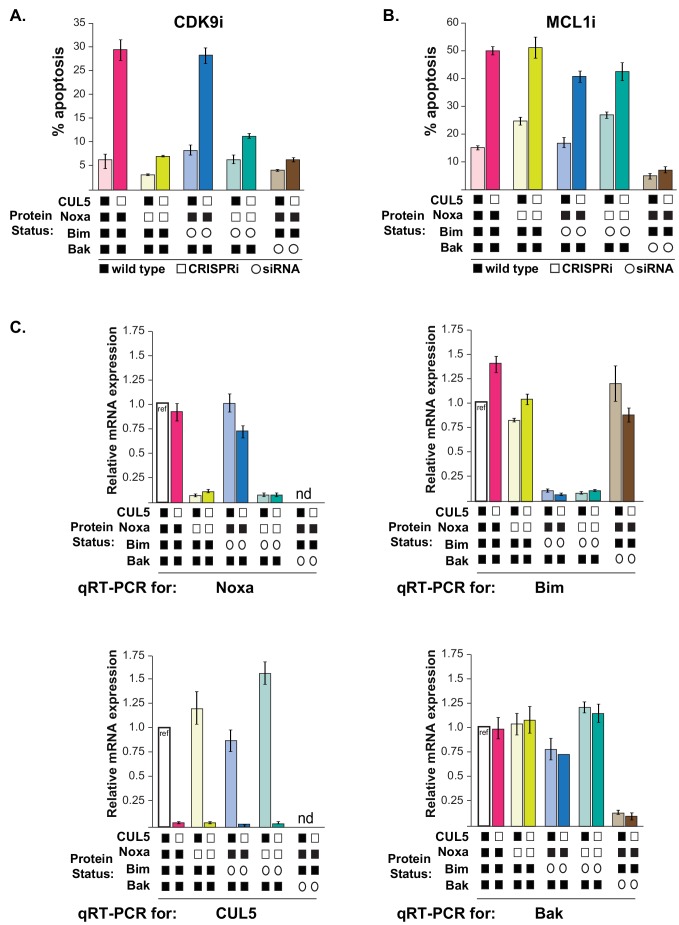
CUL5-kd cells regain resistance to CDK9i when Noxa is depleted.(A) As in Figure 5, CUL5 and Noxa were knocked down in dCas9-KRAB-expressing LK2 cells by selecting for corresponding sgRNAs. Bim and Bak were knocked down by siRNA. Apoptosis was measured using Cell Event detection by flow cytometry after treatment with 3 μM CDK9i for 6 hr. Bar graphs depict an independent set of transductions and siRNA transfections from Figure 5. Error bars are standard deviations of 3 biological drug treatment replicates. (B) Genetic manipulations were performed and apoptosis was measured as in (A) following MCL1i treatment. (C) Representative data set illustrating knockdown efficiency by qRT-PCR for genetic manipulations shown in (Figure 5A–B). Error bars are standard deviations of technical replicates. qRT-PCR was conducted to validate knockdown for each biological replicate of sgRNA transduction and siRNA transfection. nd, not determined.